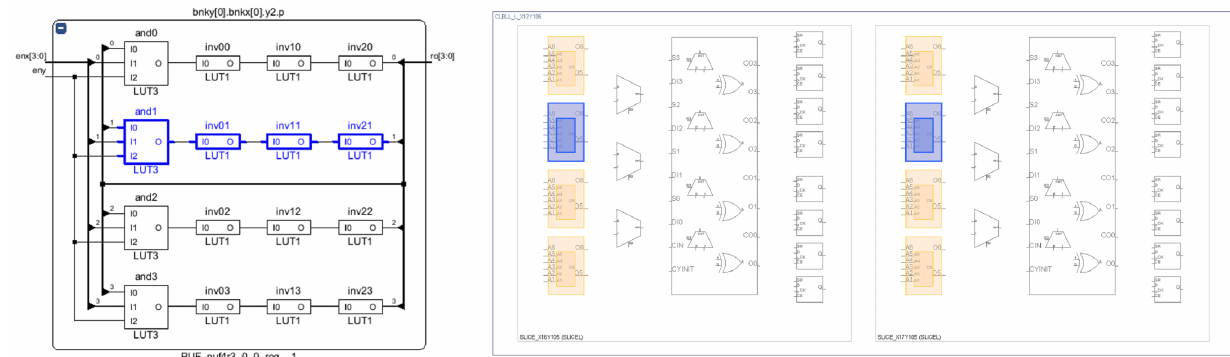
Figure 2. Four 4-stage ROs implemented on a CLB: schematic ( left ) and device representation ( right ), highlighting one of the ring